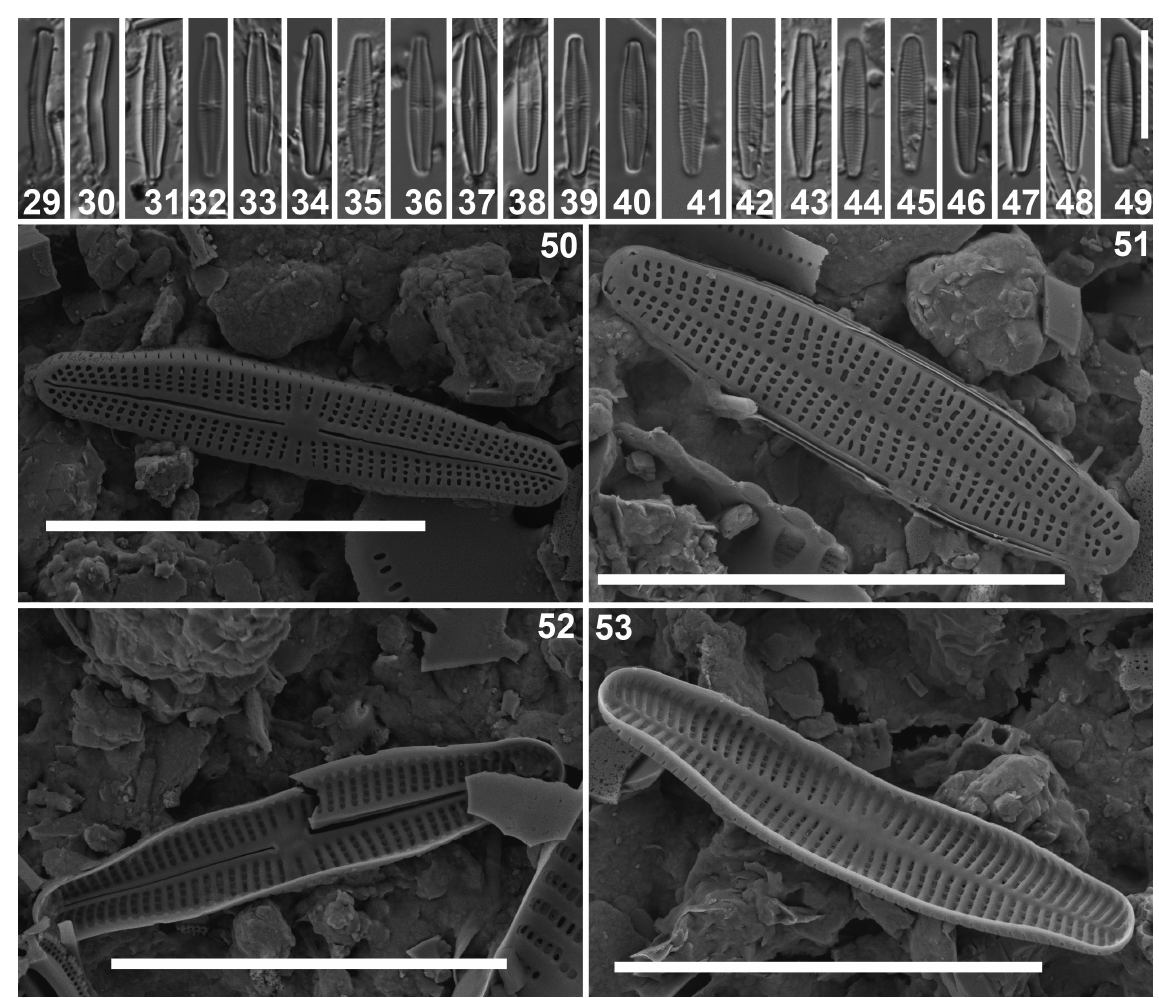
Figs 29-53. Achnanthidium maritimo-antarcticum Van de Vijver & Kopalová sp. nov. Light and scanning electron micrographs of the type population on Byers Peninsula (Livingston Island). 29-30 . LM views of some frustules in girdle view. 31-40 . LM views of raphe valves. 41-49 . LM views of rapheless valves. 50 . SEM external view of an entire raphe valve. 51 . SEM external view of an entire rapheless valve. 52 . SEM internal view of an entire raphe valve. 53 . SEM internal view of an entire rapheless valve. Scale bars represent 10